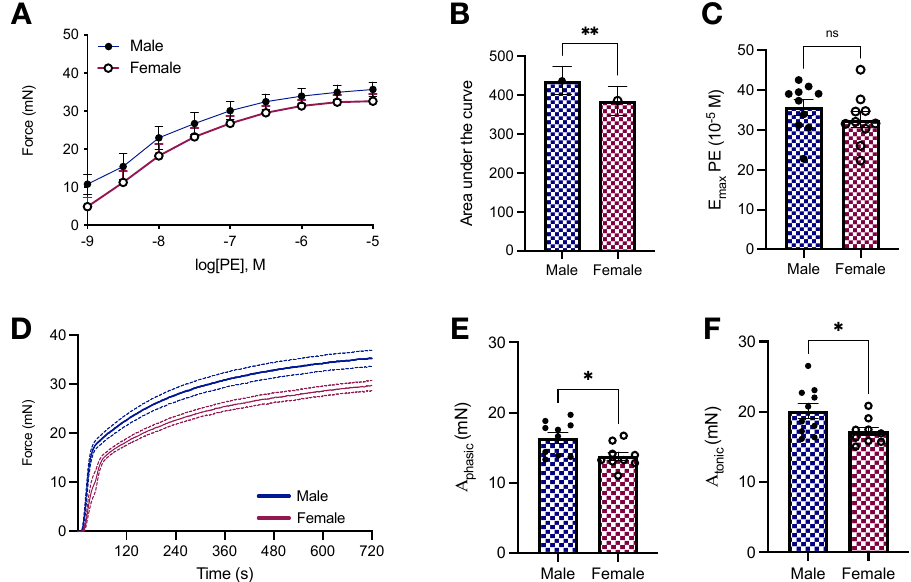
Figure 2. Young female Wistar rats display increased aIMT-to-diameter ratio. ( A ) Representative images, ( B ) long diameter, ( C ) short diameter, ( D ) aortic intima-media thickness (aIMT), ( E ) aIMT-to- diameter ratio, and ( F ) cross-sectional area. Data are presented as means ± SEM, n = 5. * p < 0.05, *** p < 0.001, **** p < 0.0001, and ns. p > 0.05 using two-tailed Student’s t -test. Scale bar: 500 µ m.